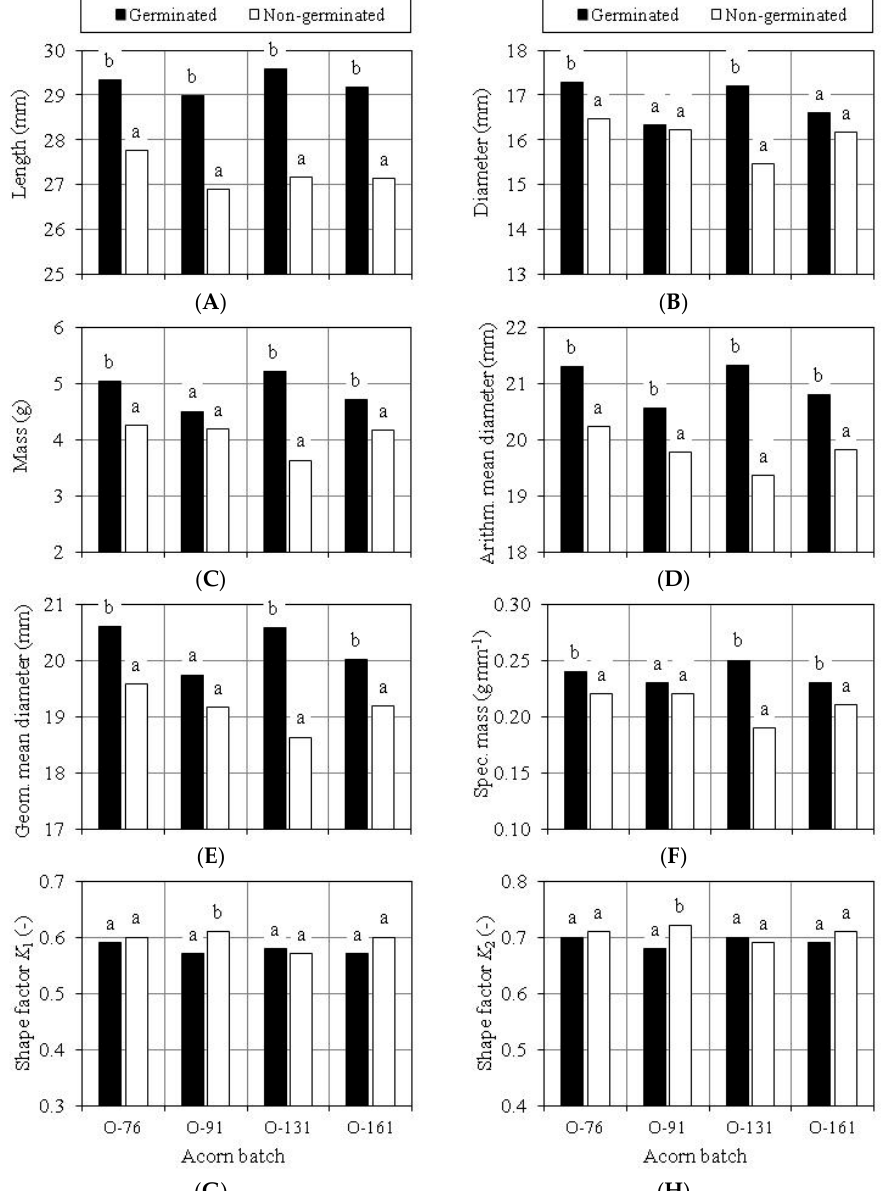
Figure 3. Significance of differences in the length ( A ), diameter ( B ), mass ( C ), arithmetic mean diameter ( D ), geometric mean diameter ( E ), specific mass ( F ), shape factor K 1 ( G ) and shape factor K 2 ( H ) of germinated and non-germinated complete acorns; a, b—different letters denote statistically significant differences.